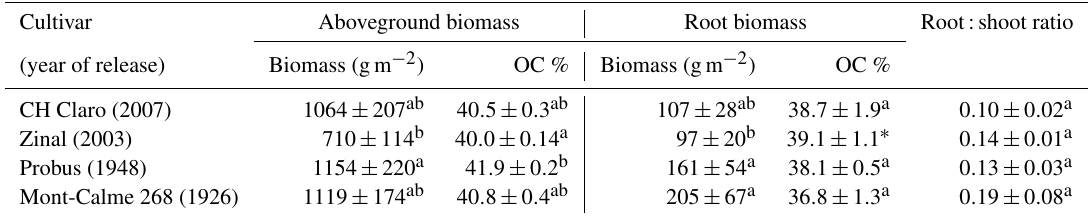
Table 1. Characteristics ( ± standard error, n = 3) of the biomass of the different wheat cultivars at the end of the experiment. Values that share a letter in the same column are not significantly different.